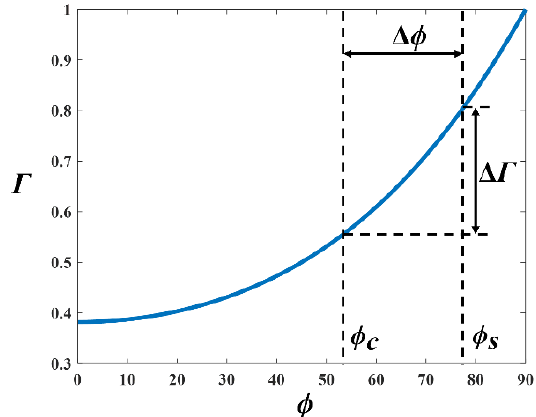
Figure 3. Schematic diagram of reflection in cascaded tunnel.